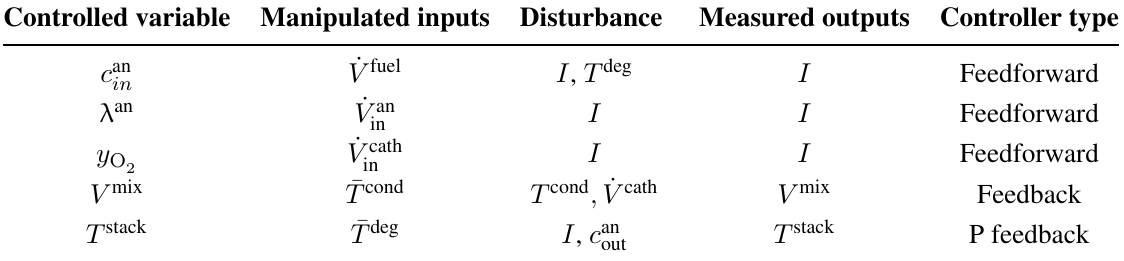
Table 2. Summary of the controllers for the reference system